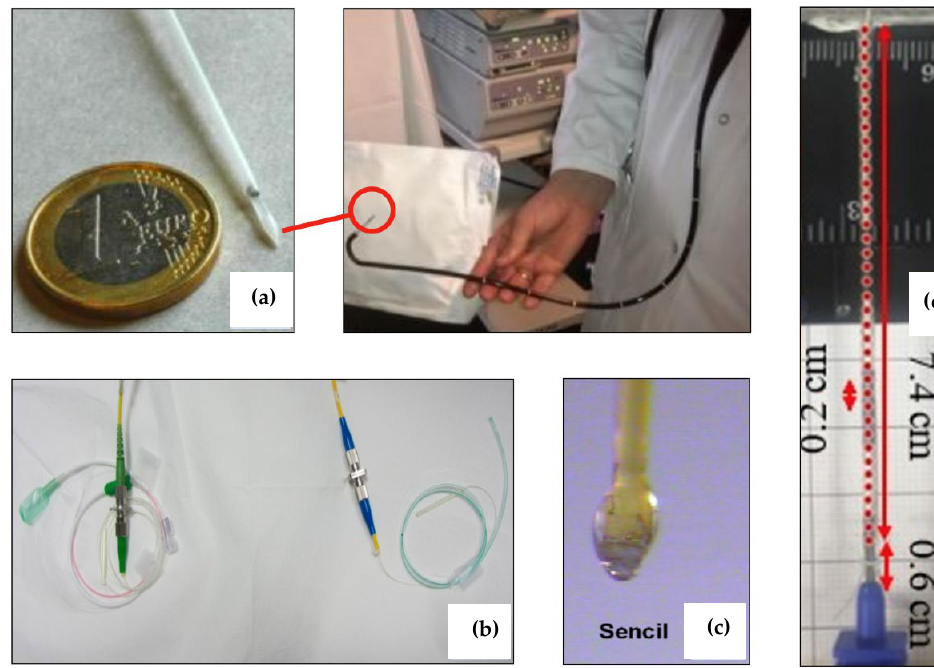
Figure 10. Example of proposed packaging for fiber optic biosensing applications: ( a ) Endoscopic packaging for in situ detection of cancer biomarkers (image reproduced from [78]); ( b ) Urologic packaging, with pressure sensors embodied in a rectal catheter (left fiber) and an abdominal catheter (right fiber) (image reproduced from [79]); ( c ) SencilTM (sensory cilia) packaging for subcutaneous fluorescence sensing (image reproduced from [80]); ( d ) Epidural needle for percutaneous insertion embodying a network of fiber sensors (image reproduced from [81]).